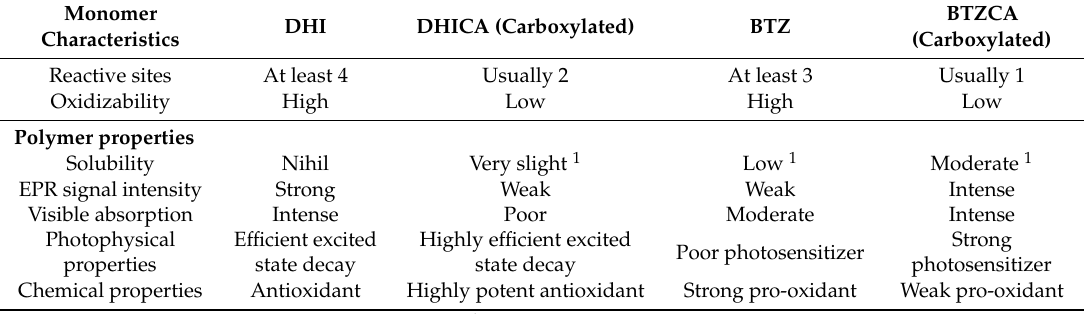
Table 3. Comparison of the properties of eu-/pheo-melanins from carboxylated/non-carboxylated